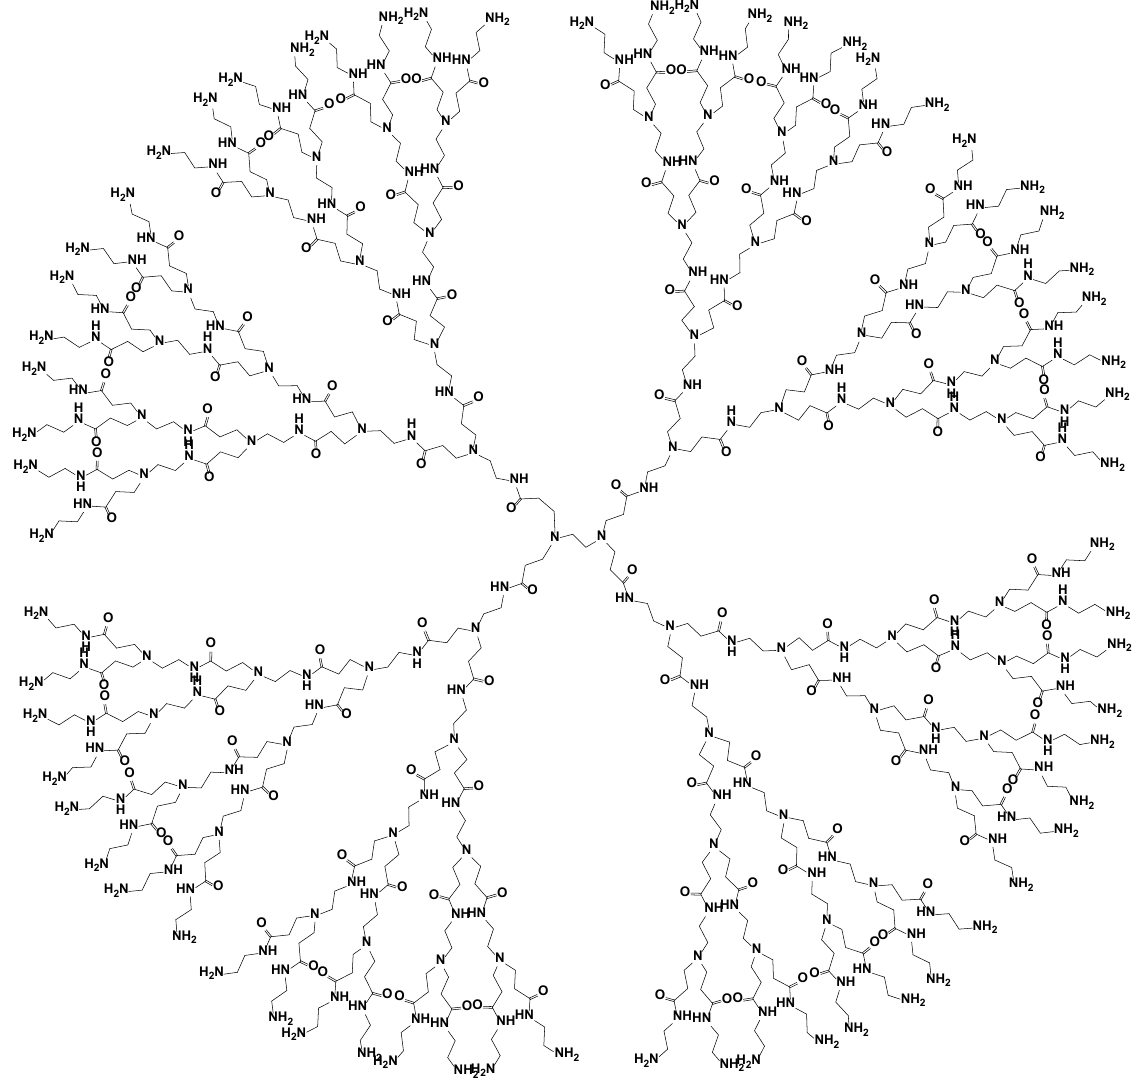
Figure 1: Molecular structure of fourth-generation poly(amidoamine) dendrimer (Kesharwani et al. ,